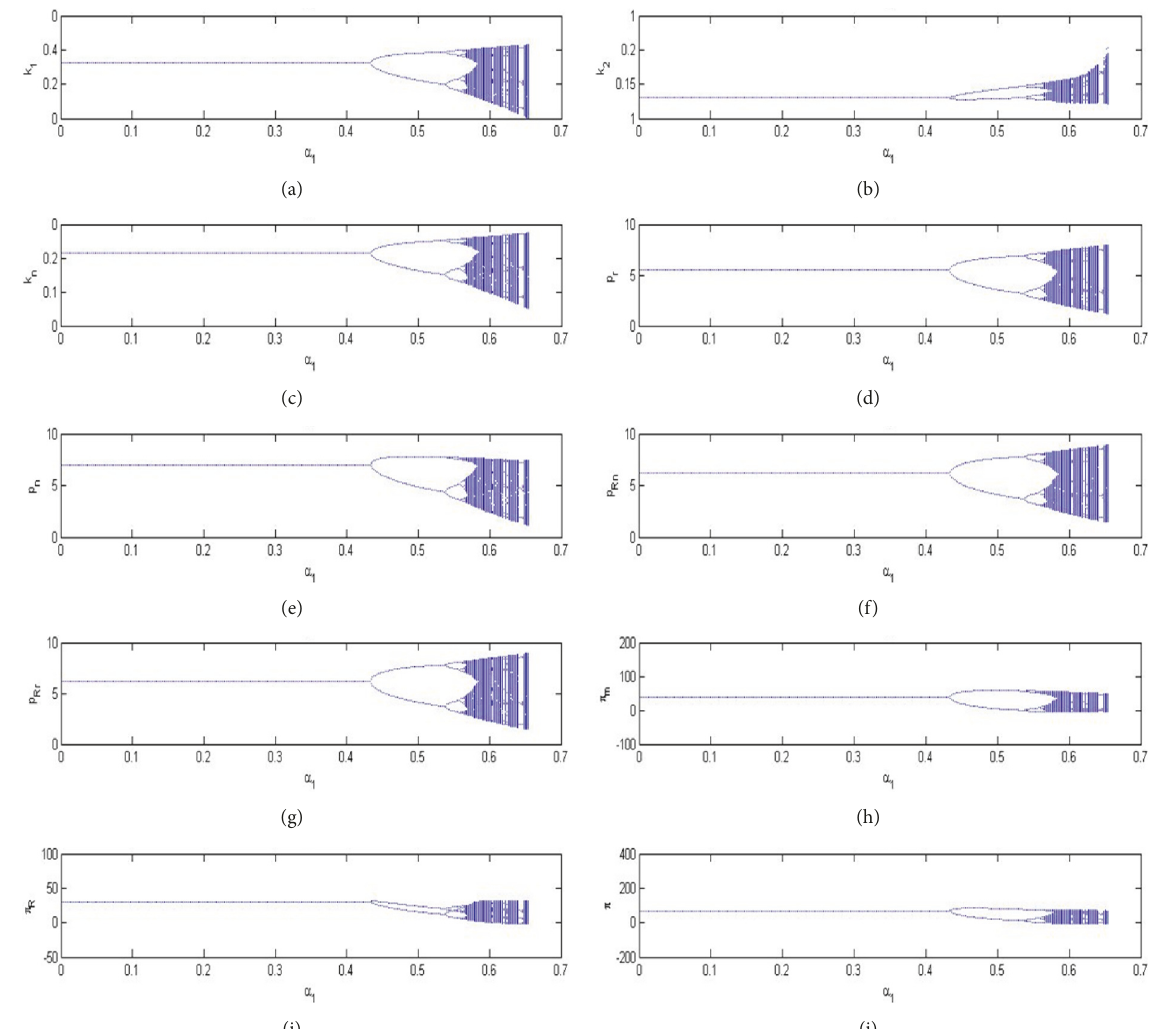
Figure 2: Bifurcation diagrams of the supply chain system (9) with the adjustment speed 𝛼 1